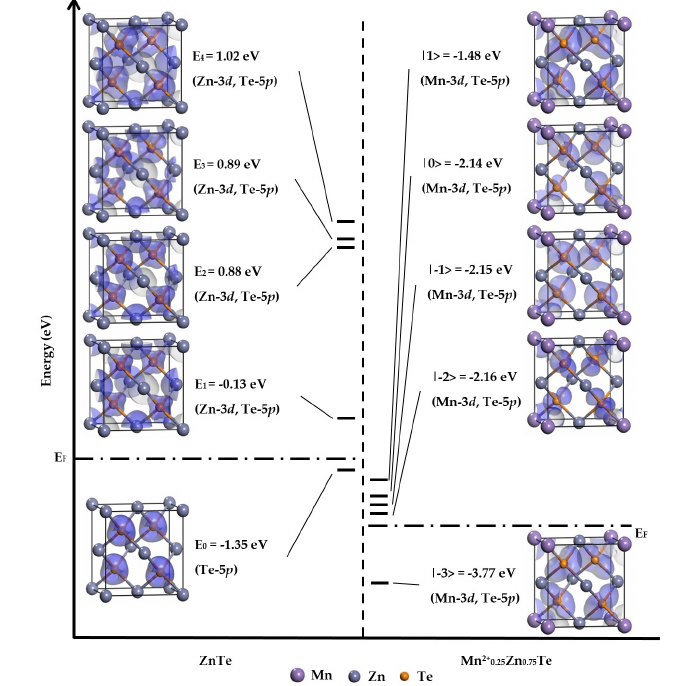
Figure 4. Left (Right) panel: HOMO and LUMO slab isosurfaces of 8-atom ZnTe (Mn 2 + 0.25 Zn 0.75 Te) cells arranged by energy and denoted by the shade of purple. The atoms are represented by spheres: Mn (purple), Zn (gray, dark), and Te